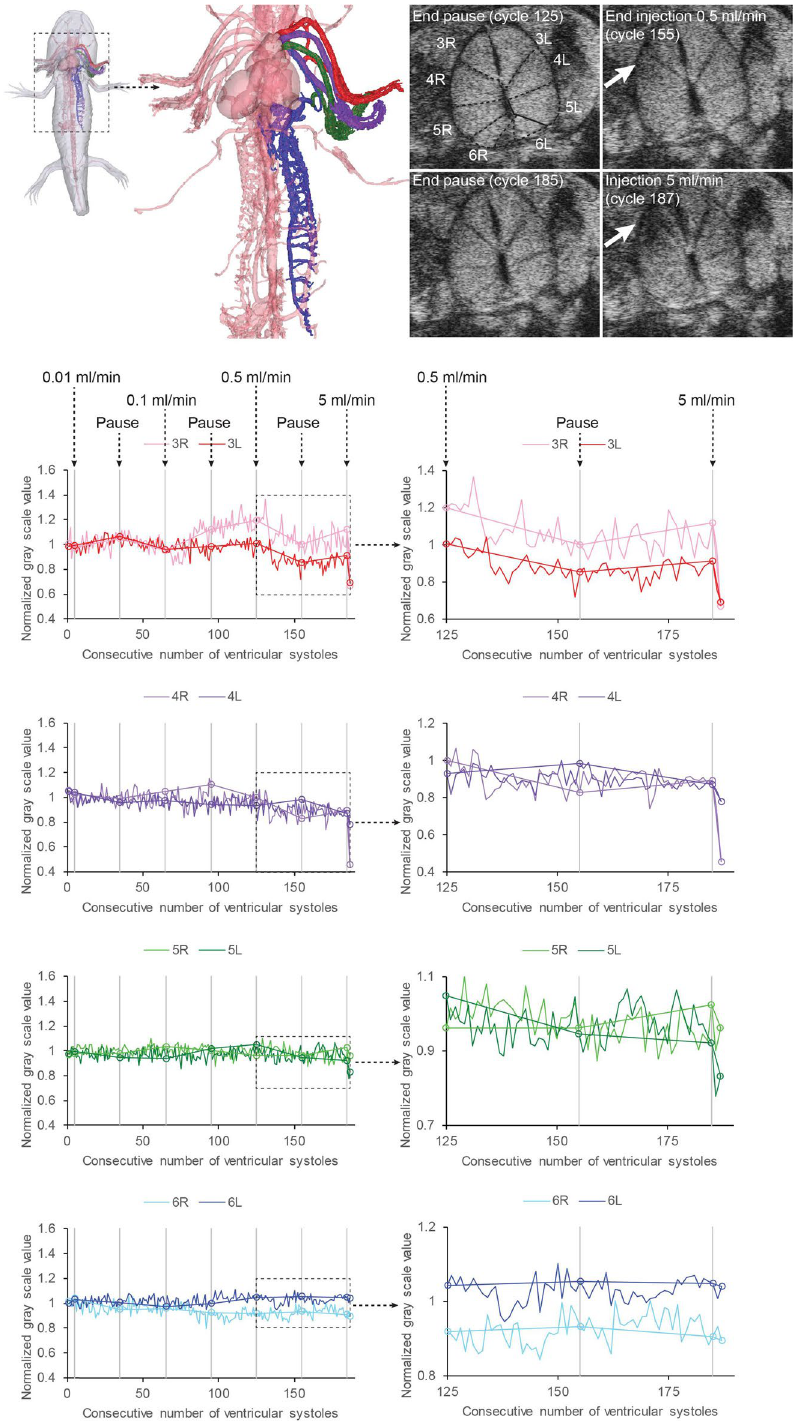
Figure 4. Cardiac flow separation in the axolotl demonstrated with ultrasonography. Top left: Anatomical model of the gill arches in the axolotl (3rd arch red, 4th arch purple, 5th arch green, 6th arch blue). Top right: Ultrasonographic transversal cross sections in the outflow tract at four time points in the injection series of negative contrast agent (amphibian Ringer’s solution). Notice the signal decrease (arrows) as diluted blood perfuse the three ventral gill arches after 30 and 3 cardiac cycles of contrast agent infusion at 0.5 and 5 ml min −1 respectively. Main part: Signal traces in right and left arches over time. Traces on the right are magnifications of the last 63 cardiac cycles with a high rate of infusion of contrast agent. Notice the final signal decrease in the 3rd, 4th, and 5th gill arches supplying the gills but not in the 6th gill arch supplying the lungs indicating a lack of complete mixing of blood in the heart as hypointense contrast agent is injected into the sinus venosus at a high flow rate (5ml min -1